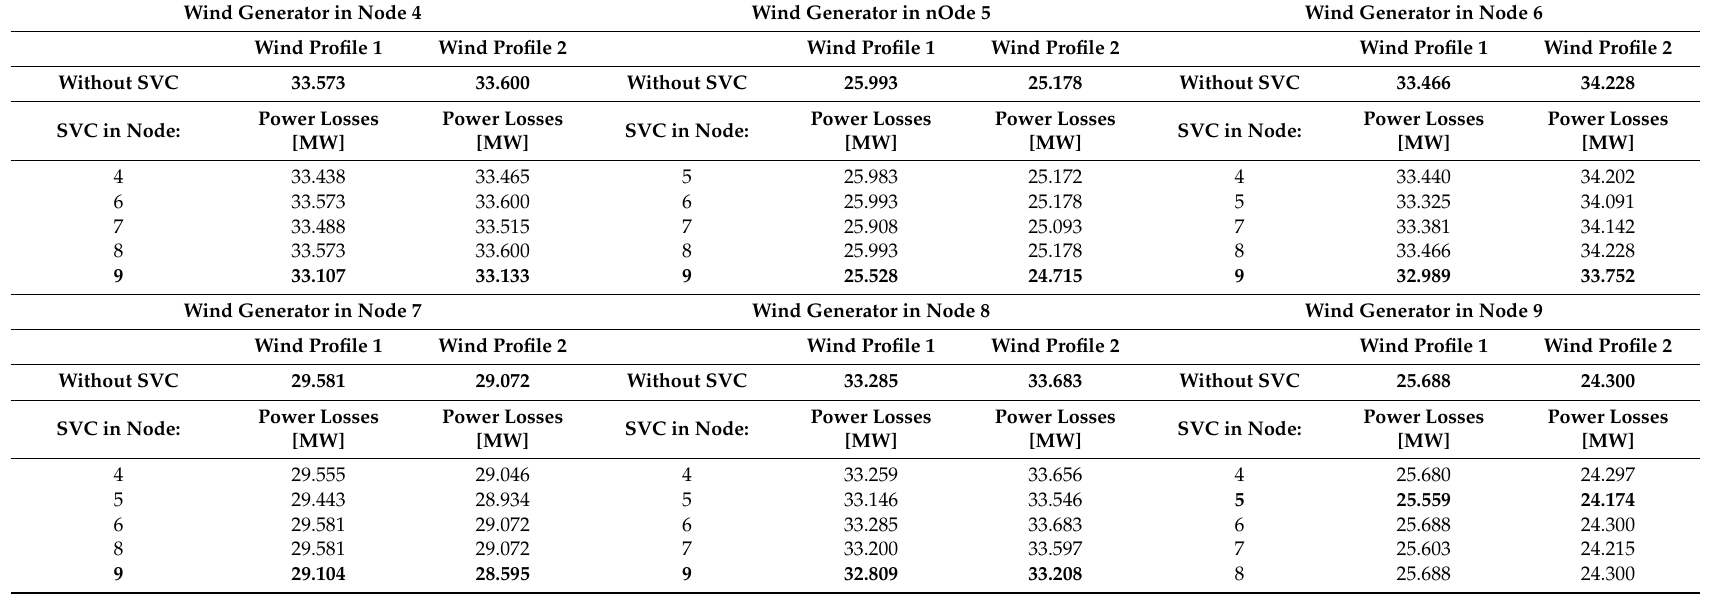
Table 10. Power system losses in the case of a wind generator and di ff erent SVC